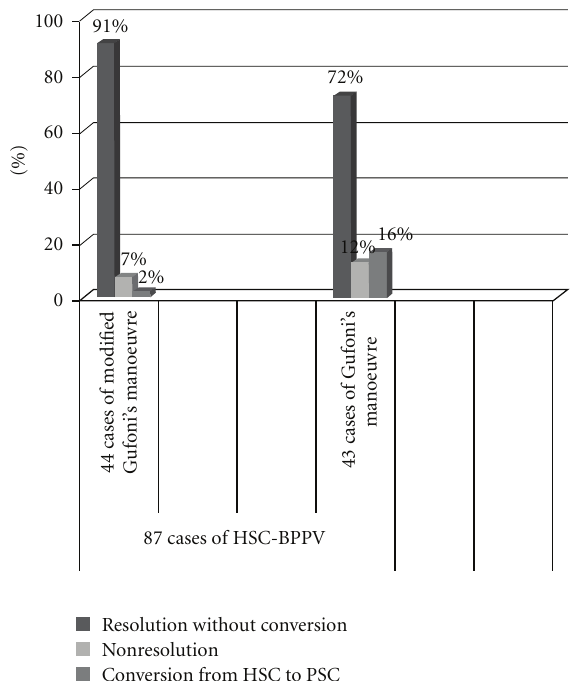
Figure 3: Comparison of results obtained with the 2 rehabilitation techniques: Modified Gufoni’s manoeuvre and Gufoni’s manoeu-